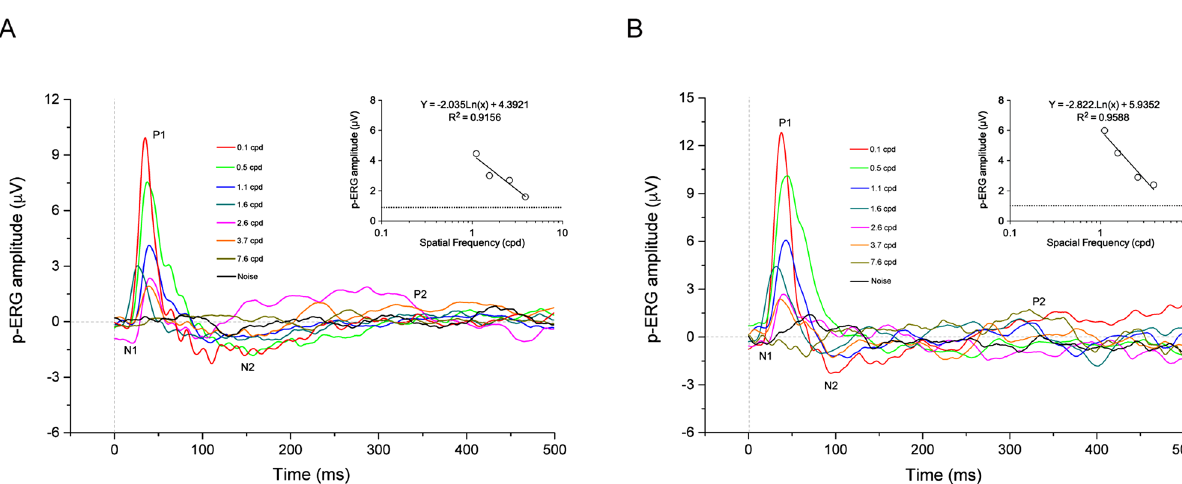
Figure 3. Representative p-ERG traces recorded in response to stimulation with sinusoidal gratings of increasing spatial frequency during the first ( A ) and second ( B ) electrophysiological session. The analysis of the electroretinographic responses showed the progressive decrease of p-ERG amplitude (ΔN1-P1) after enhancing the spatial frequency (different colors) of visual stimuli. Insert panels depict the regression line from which retinal acuity is computed. cpd, cycles per